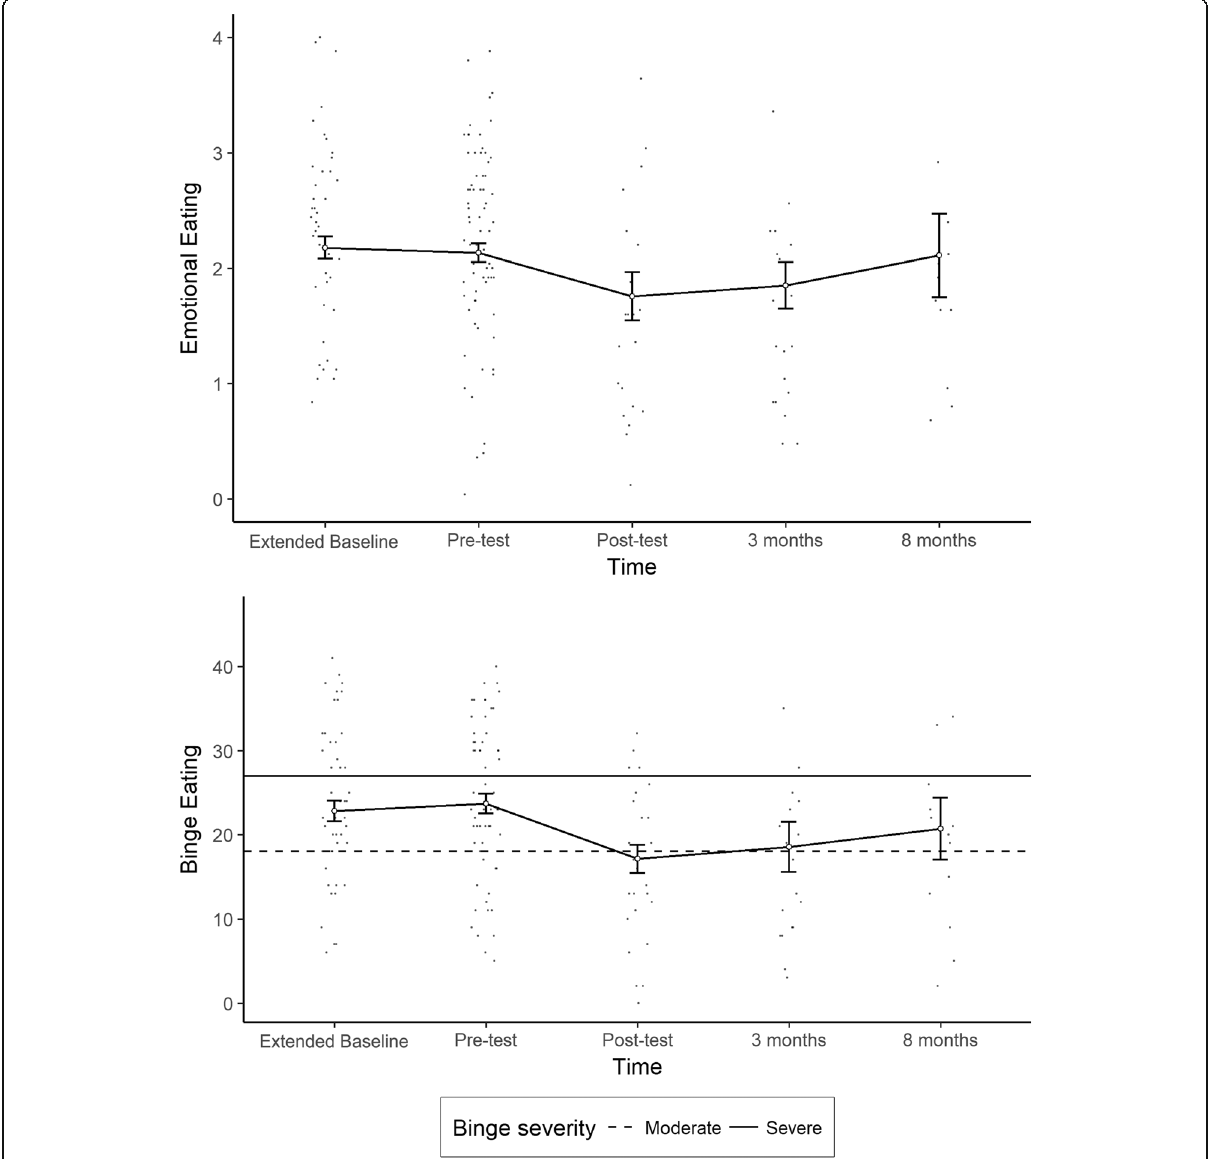
Fig. 2 Trajectories of problematic eating behaviors across time. Dots represent individual scores for each timepoint. White dots and error bars indicate means and 95% confidence intervals for each timepoint. On the binge eating graph, the horizontal lines represent cutoff scores for moderate binge eating (dashed line) and severe binge eating (solid